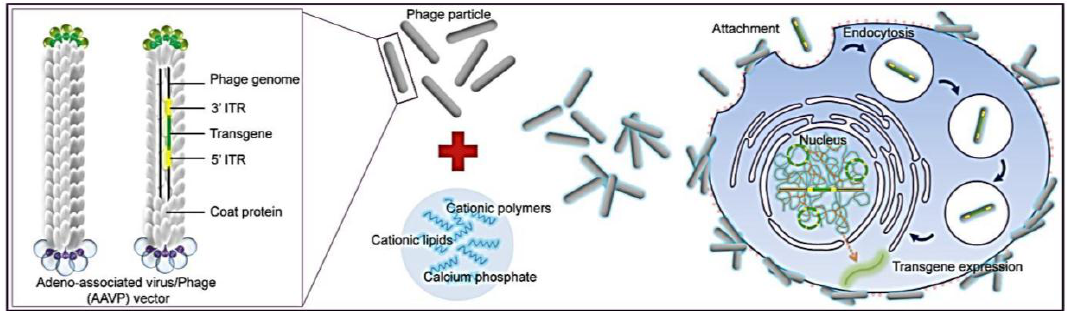
Figure 1. Schematic diagram of the hybrid bacteriophage/transfection reagents system. Negatively charged bacteriophage vectors were electrostatically mixed with transfection reagents to form hybrid bacteriophage complexes. A hybrid vector consists of the filamentous M13 bacteriophage and a transfection reagent. The phage serves as a transgene carrier. ITR, inverted terminal repeats of adeno-associated virus serotype 2 (AAV2).